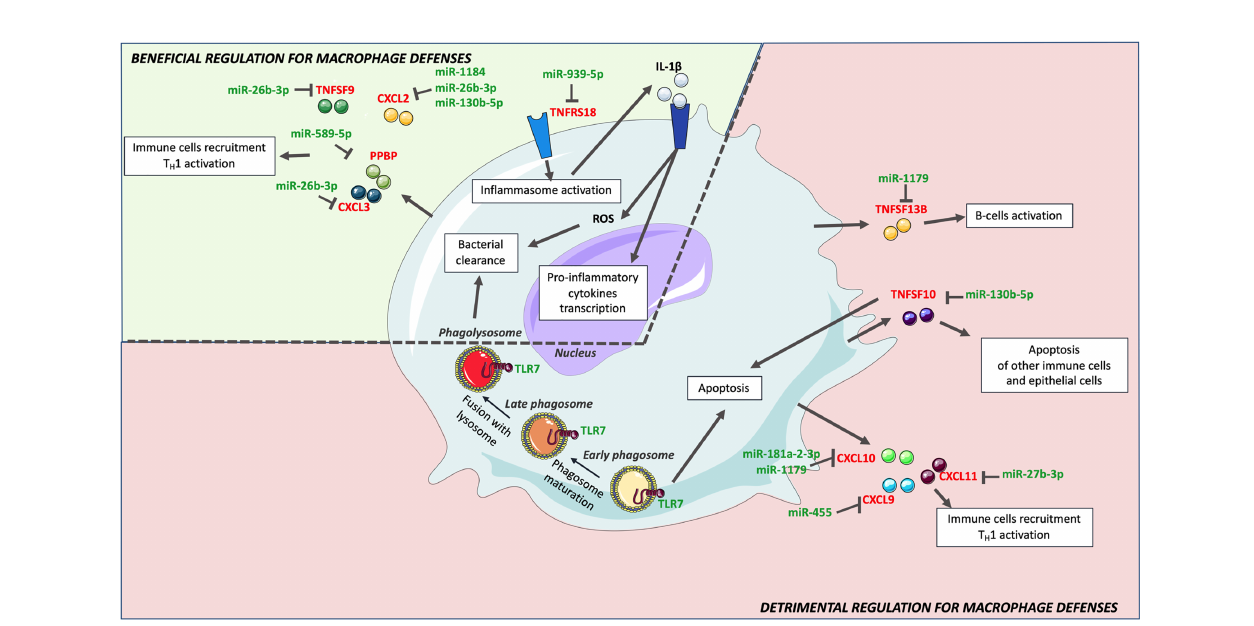
FIGURE 5 | H37R-speci fi c macrophage in fl ammatory response genes and associated miRNAs. Upon H37Rv infection, macrophages upregulated CXCL2, CXCL3, IL24 , PPBP, TNFRSF18 and TNSF9 , which have a bene fi cial effect on macrophages defense against Mtb. Downregulation of miR-19b-1-5p, miR-26b-3p, miR- 130b-5p, miR-939-5p, miR-589-5p and miR-1184 might however limit the expression of these genes. Although H37Rv led to upregulation of CCL8, CCL17, CXCL9 , CXCL10, CXCL11, TNFSF10 and TNFSF13B , their expression levels were signi fi cantly lower than that induced by Mm -infection. Hence, H37Rv mediated lower expression of these genes might rather be detrimental for macrophage defense. Their expression might be limited by miR-27b-3p, miR-130b-5p, miR-181a-2-3p, miR-425p, miR-455 and